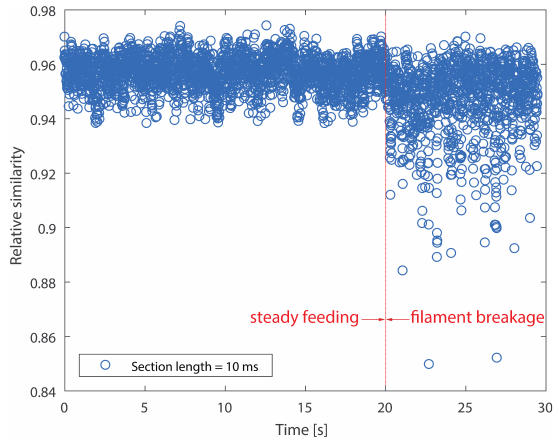
Figure 10. Relative similarity of the AE signal for Test #1 (section length = 10 ms).